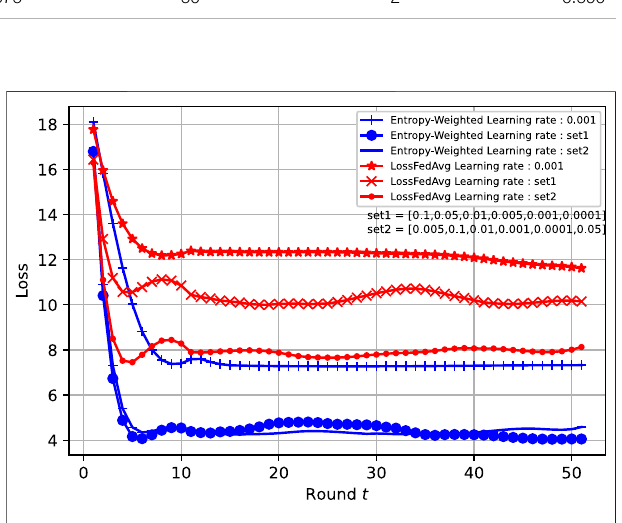
Table 2 , where FL system consists of K (cid:1) 6 DUs running local